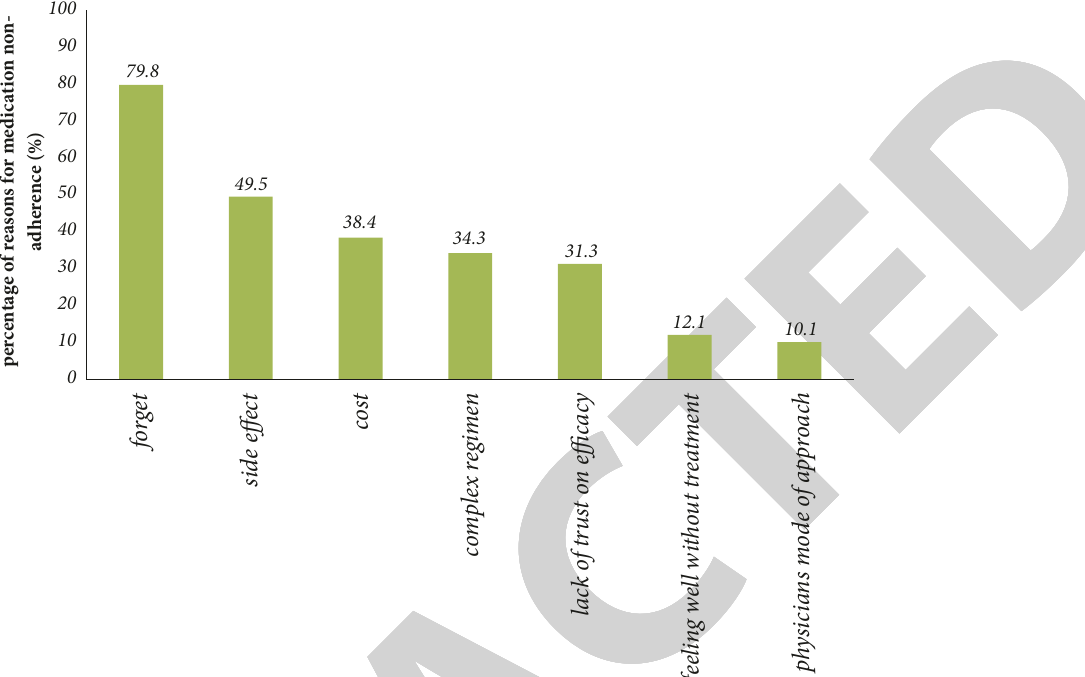
Figure 5: Reasons for medication nonadherence among chronic kidney disease patients attending the renal clinic of Tikur Anbessa Specialized